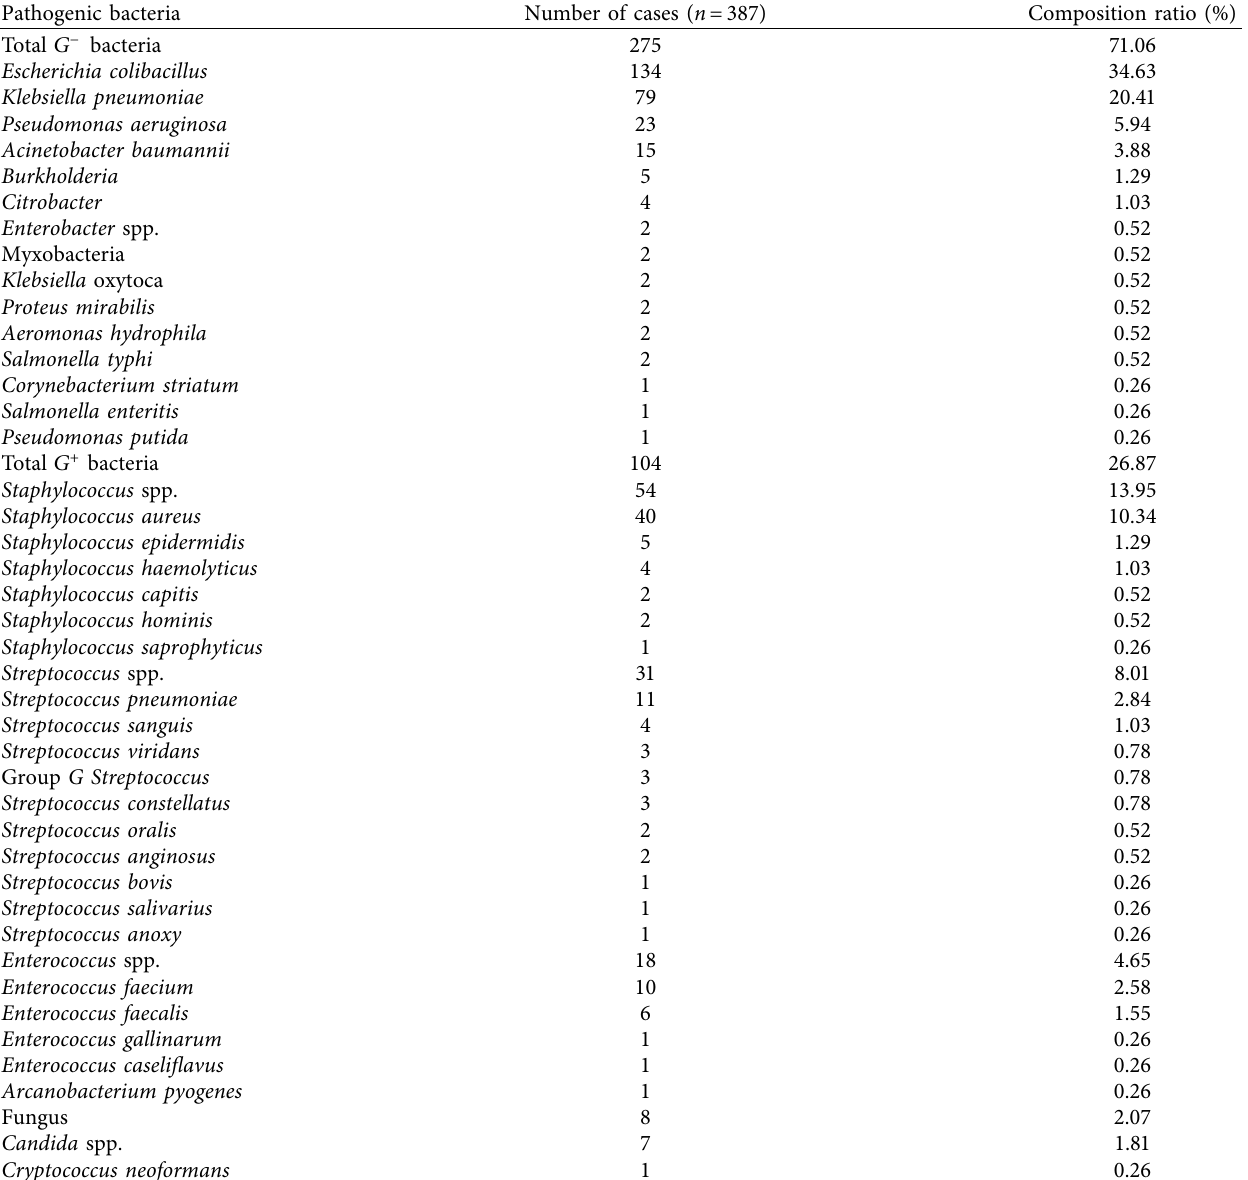
Table 4: Distribution of pathogenic bacteria detected in 387 adult blood